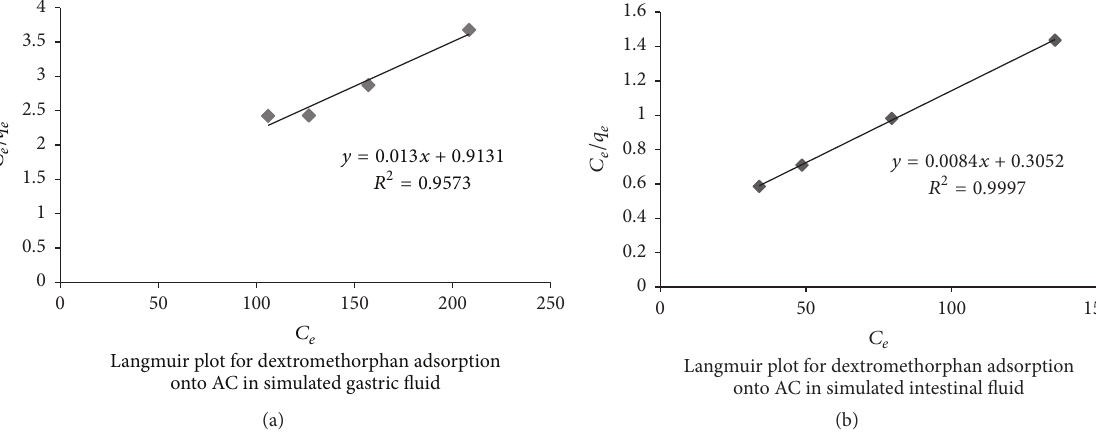
Figure 2: Langmuir plot of AC with DXM in (a) simulated gastric fluid and (b) simulated intestinal fluid.